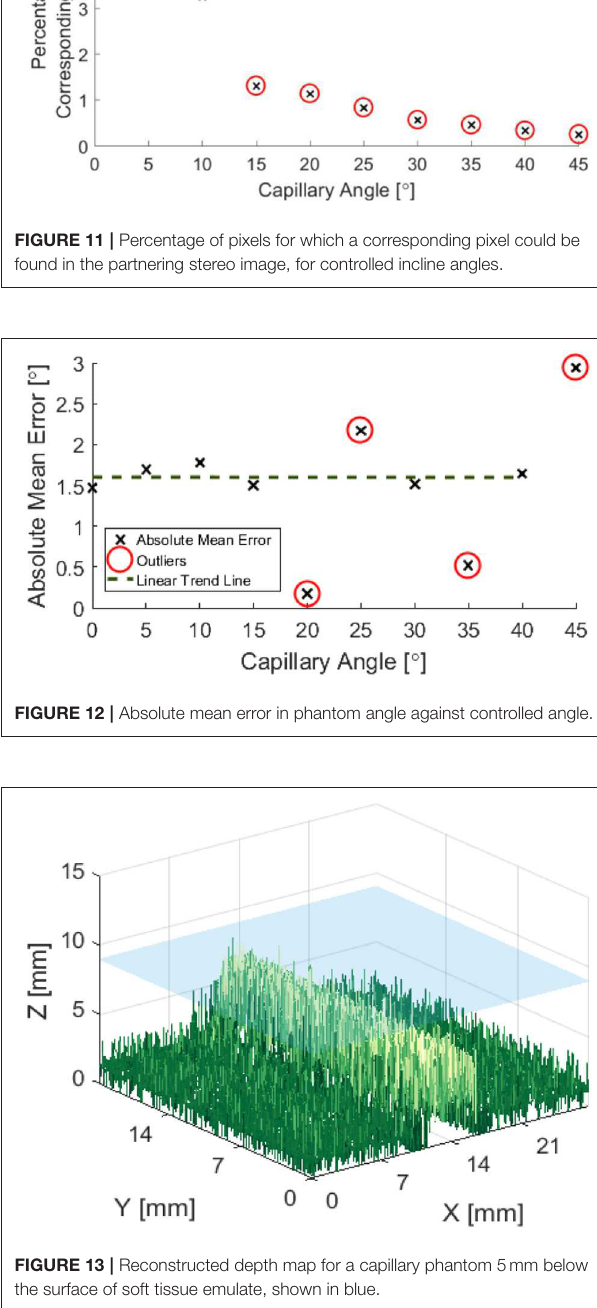
depth has been measured to a worse case accuracy of ± 3 mm and phantom angle to a constant accuracy of ± 1.6 ◦ . The errors associated with the test data are within what is generally